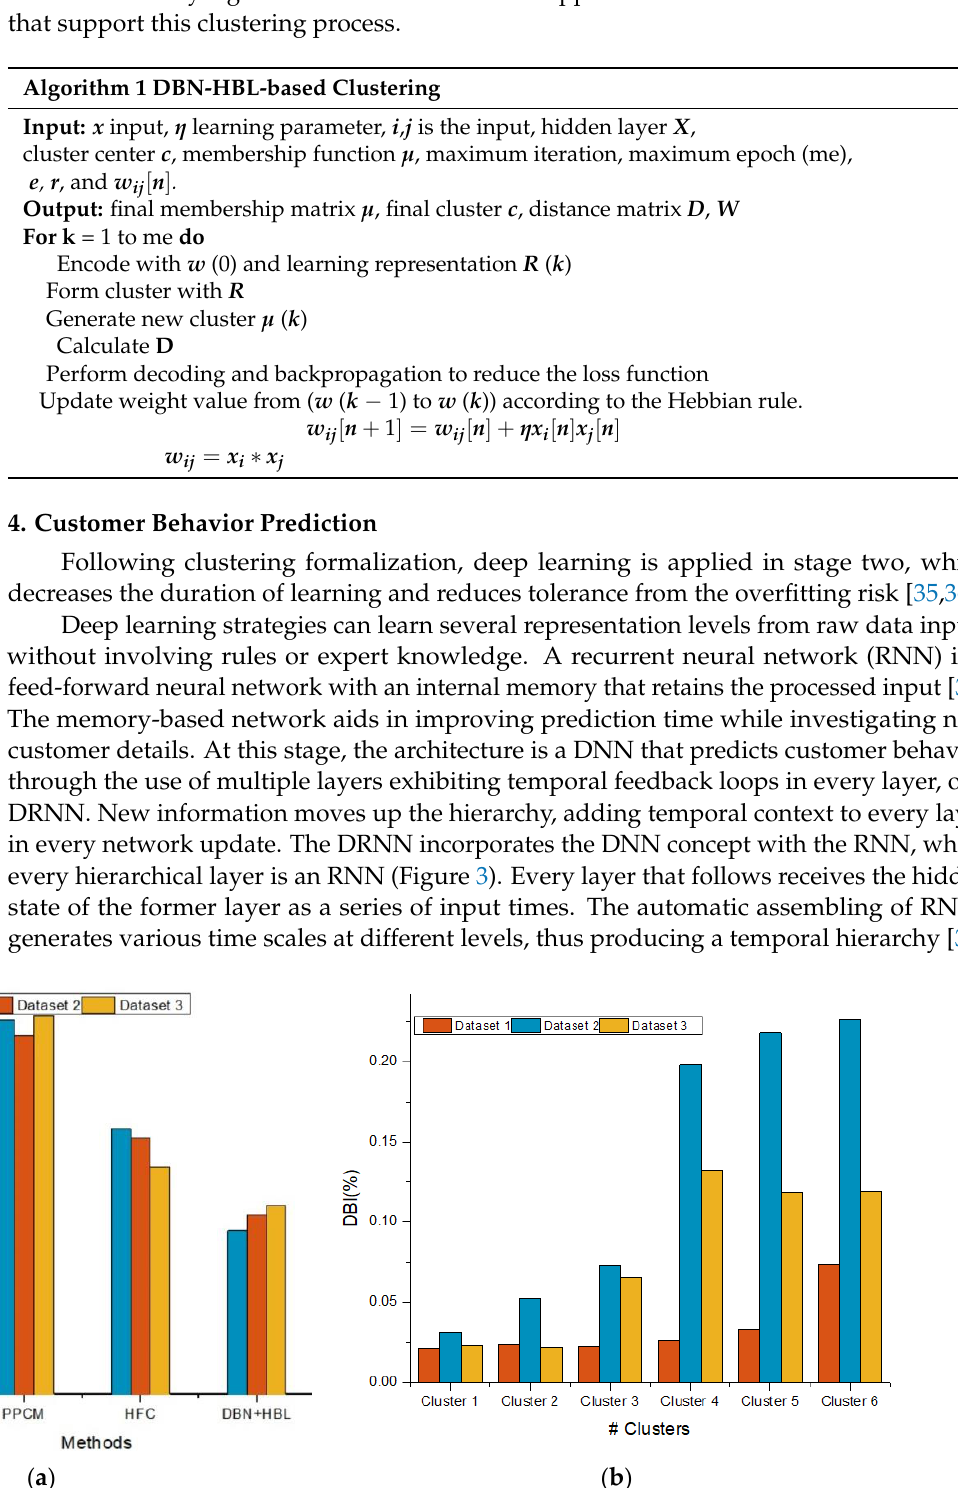
Here, the hidden layer output 𝐡 𝐭 is computed from the processing of inputs, the net- work parameter U, weight W, bias b, and hidden vector h t-1 . The estimated output is then passed to the next layer to obtain the overall output y t =σ y ( W y h t +b y ) . The output of the network y t is obtained from the output layer activation function σ y applied to the out- put of the hidden layer, the weight multiplication process, and the output layer bias value b y . During the computation, the sigmoid activation function σ= 1 1+σ -x is utilized to get the output (0 and 1 or 1 and − 1). If the output returns a 1, then the customer is considered willing to purchase the product in the future; otherwise (0 or − 1), they are not interested in purchasing the product. Additional binary classifications related to customer behavior were studied, including the attractiveness of the customer and product upselling predic- tions. This computation is more effective because the clustering process also utilizes the probability value for visible and hidden vectors. This selects the most similar and relevant information; likewise, a recurrent network also uses the P ( o u | x 1u ,……x Tu ) value for every order of customer. The probability value is computed from the customer’s previous pur- chasing orders to obtain user preferences; therefore, it minimizes the binary classification problem. Parameters tuning effects on improving the performance, such as increasing the number of neurons, batch size, and number of epochs. Hyper-parameter tuning can be performed with multiple trials until the best outcome is found. Nevertheless, the appro- priate number of epochs can be selected by an early stopping mechanism, which can stop the training process after a number of epochs when finding the best validation numbers. Furthermore, the system should concentrate on the maximization error rate classification issue. This was resolved by optimizing the network parameters; the optimization was conducted by applying the BOA. The BOA resolves convergence issues by using the ob- jective function, which also diminishes gradient issues. Here, butterfly characteristics are utilized to achieve the objective of the work. Stimulus variance intensity ( SI ) and fragrance fr characteristics are used to identify the relationship between the network parameters.